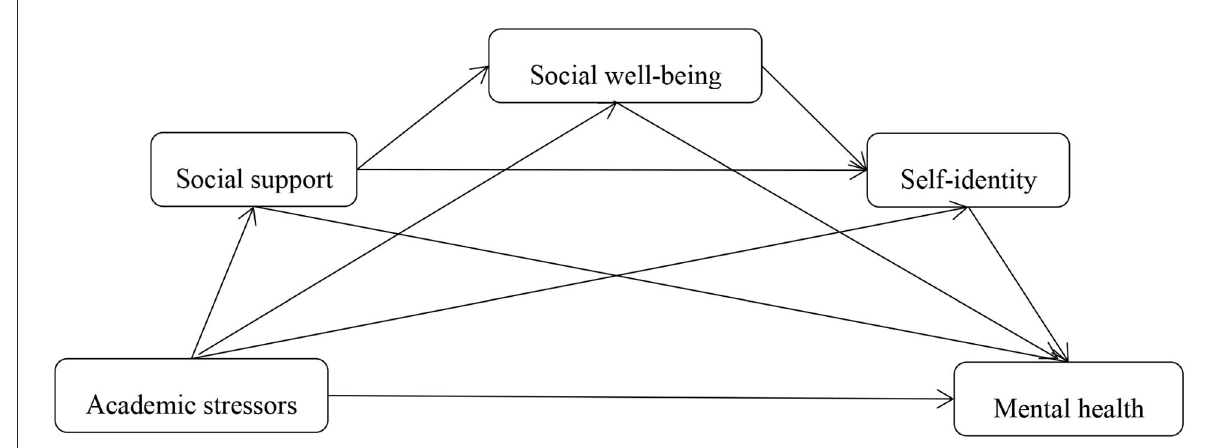
FIGURE1 The hypothesis of mediating effect of academic stressors on mental health of college